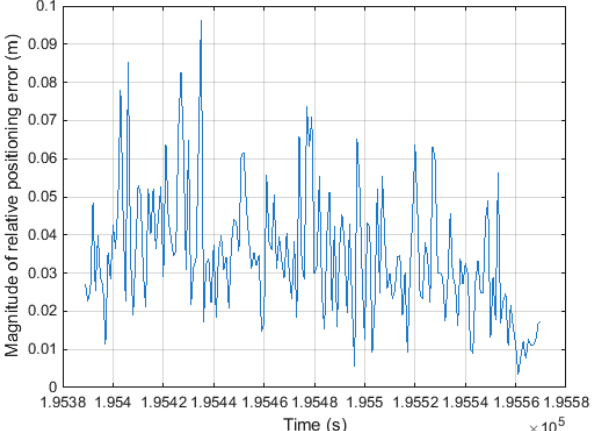
Figure 16. Magnitude of relative positioning error (dynamic